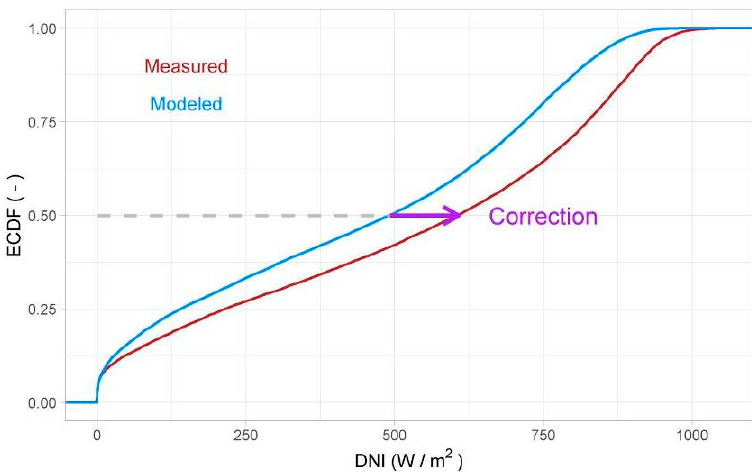
Figure 2. Empirical quantile mapping (eQM)correction for quantile 50 of modeled direct normal solar irradiance (DNI) data (blue) to match measured data (red).